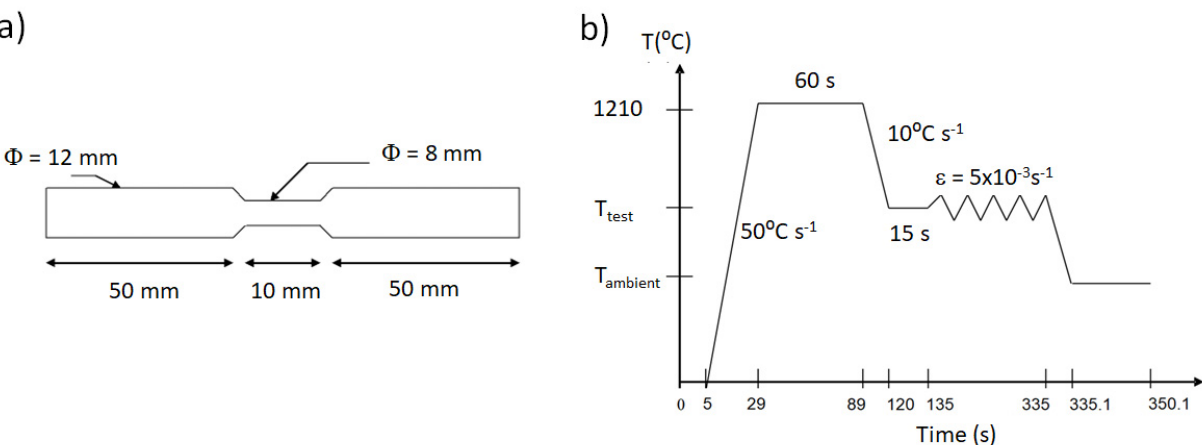
Figure 2. Schematic diagrams showing ( a ) the tensile test specimen geometry and ( b ) the thermomechanical testing cycle.